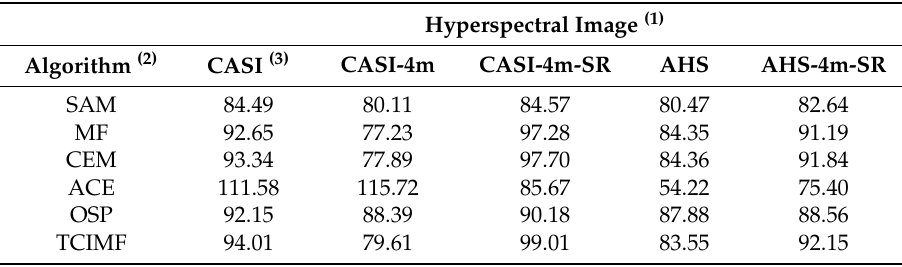
Table 4. Total area covered by S. densiflora in ha. As predicted by each spectral detection algorithms on the different hyperspectral images